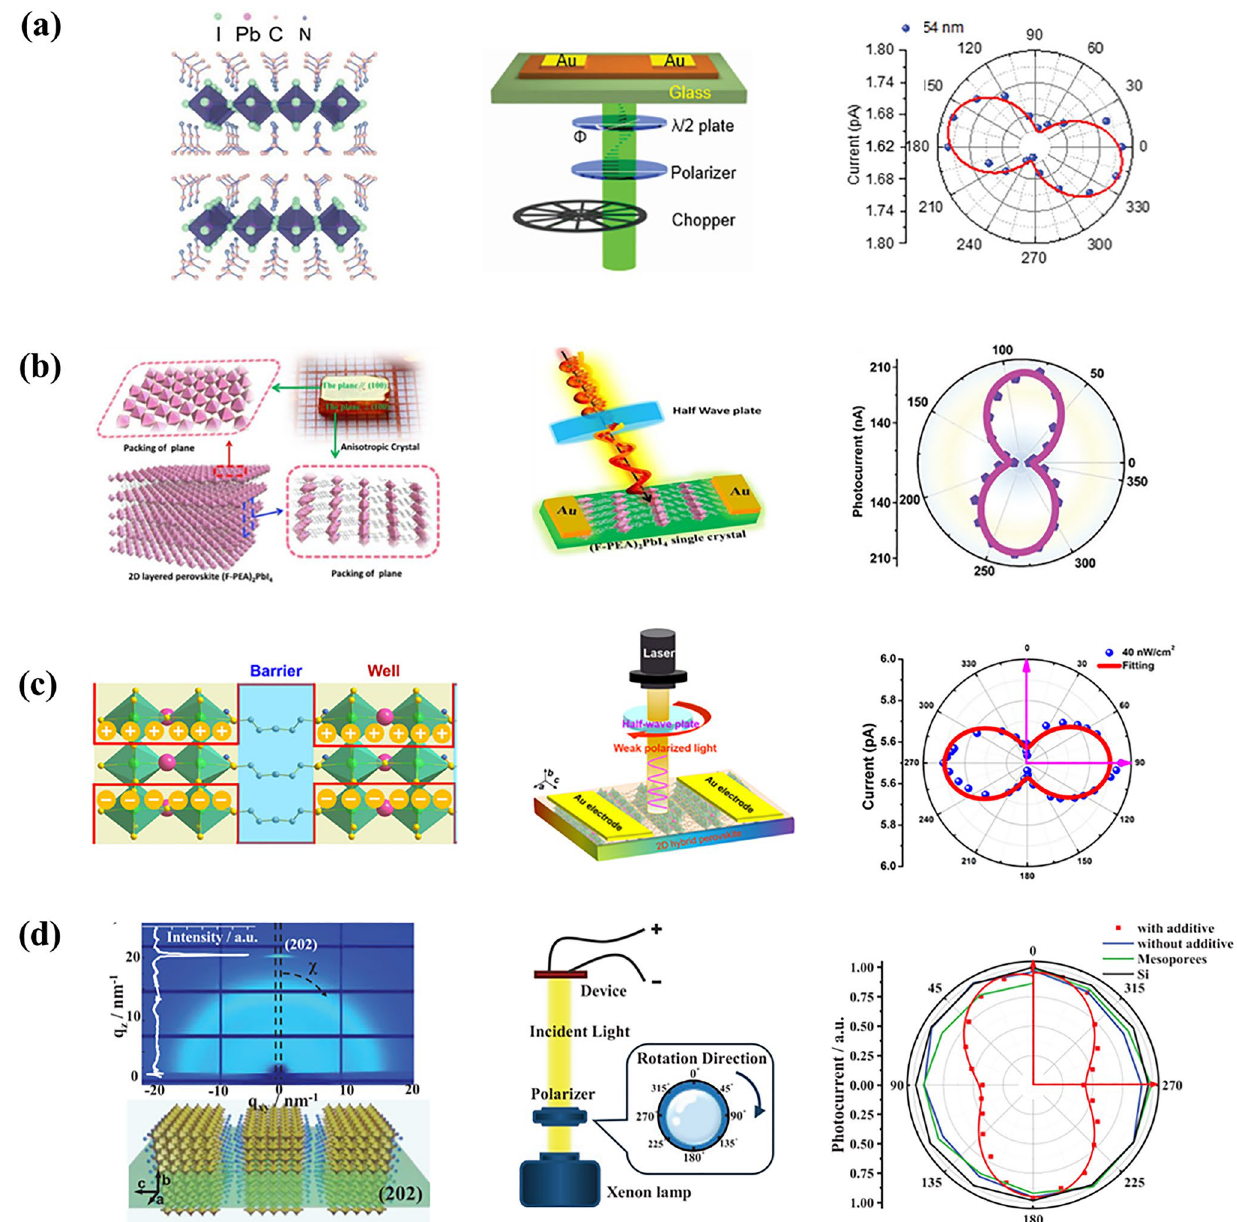
Fig. 3 Structure of different 2D perovskites, and the performance of LP-PPDs with different 2D perovskites. a ( iso -BA) 2 PbI 4 . Reproduced with permission [15], Copyright 2019, John Wiley and Sons. b (FPEA) 2 PbI 4 . Reproduced with permission [17], Copyright 2020, John Wiley and Sons. c (BPA) 2 PbBr 4 . Reproduced with permission [20], Copyright 2021, Elsevier. d PEA 2 MA 4 (Sn 0.5 Pb 0.5 ) 5 I 16 . Reproduced with permission [21], Copyright 2021, John Wiley and